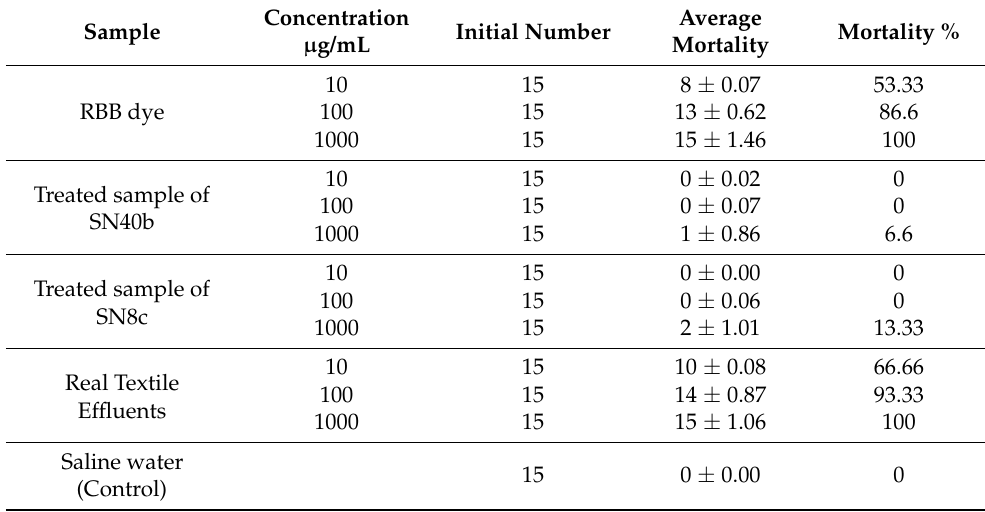
Table 3. Toxicity testing of RBB dye against Artemia salina